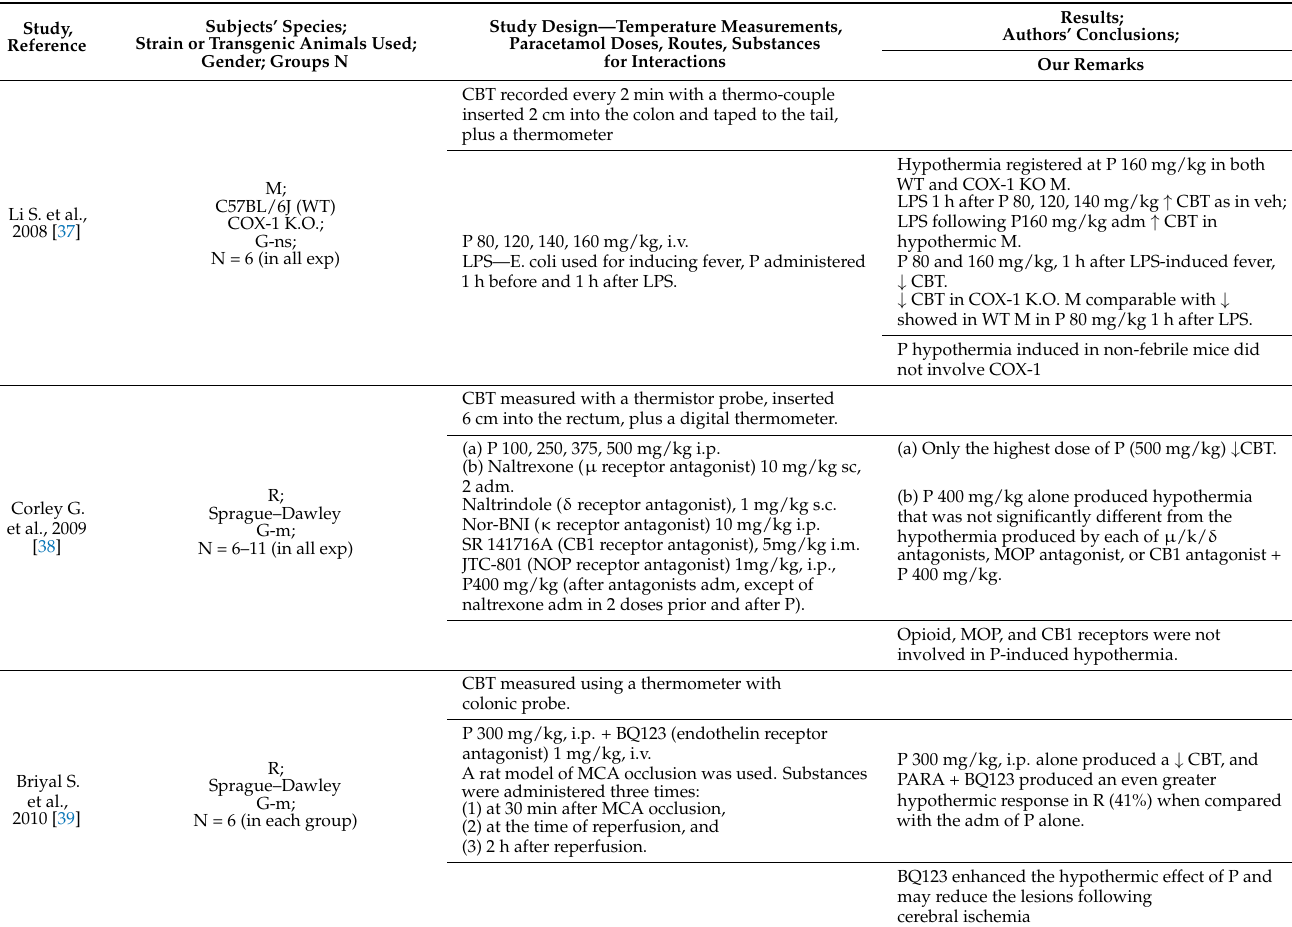
Table 1. Synthesis of the findings of the literature that presents paracetamol’s hypothermic effects in